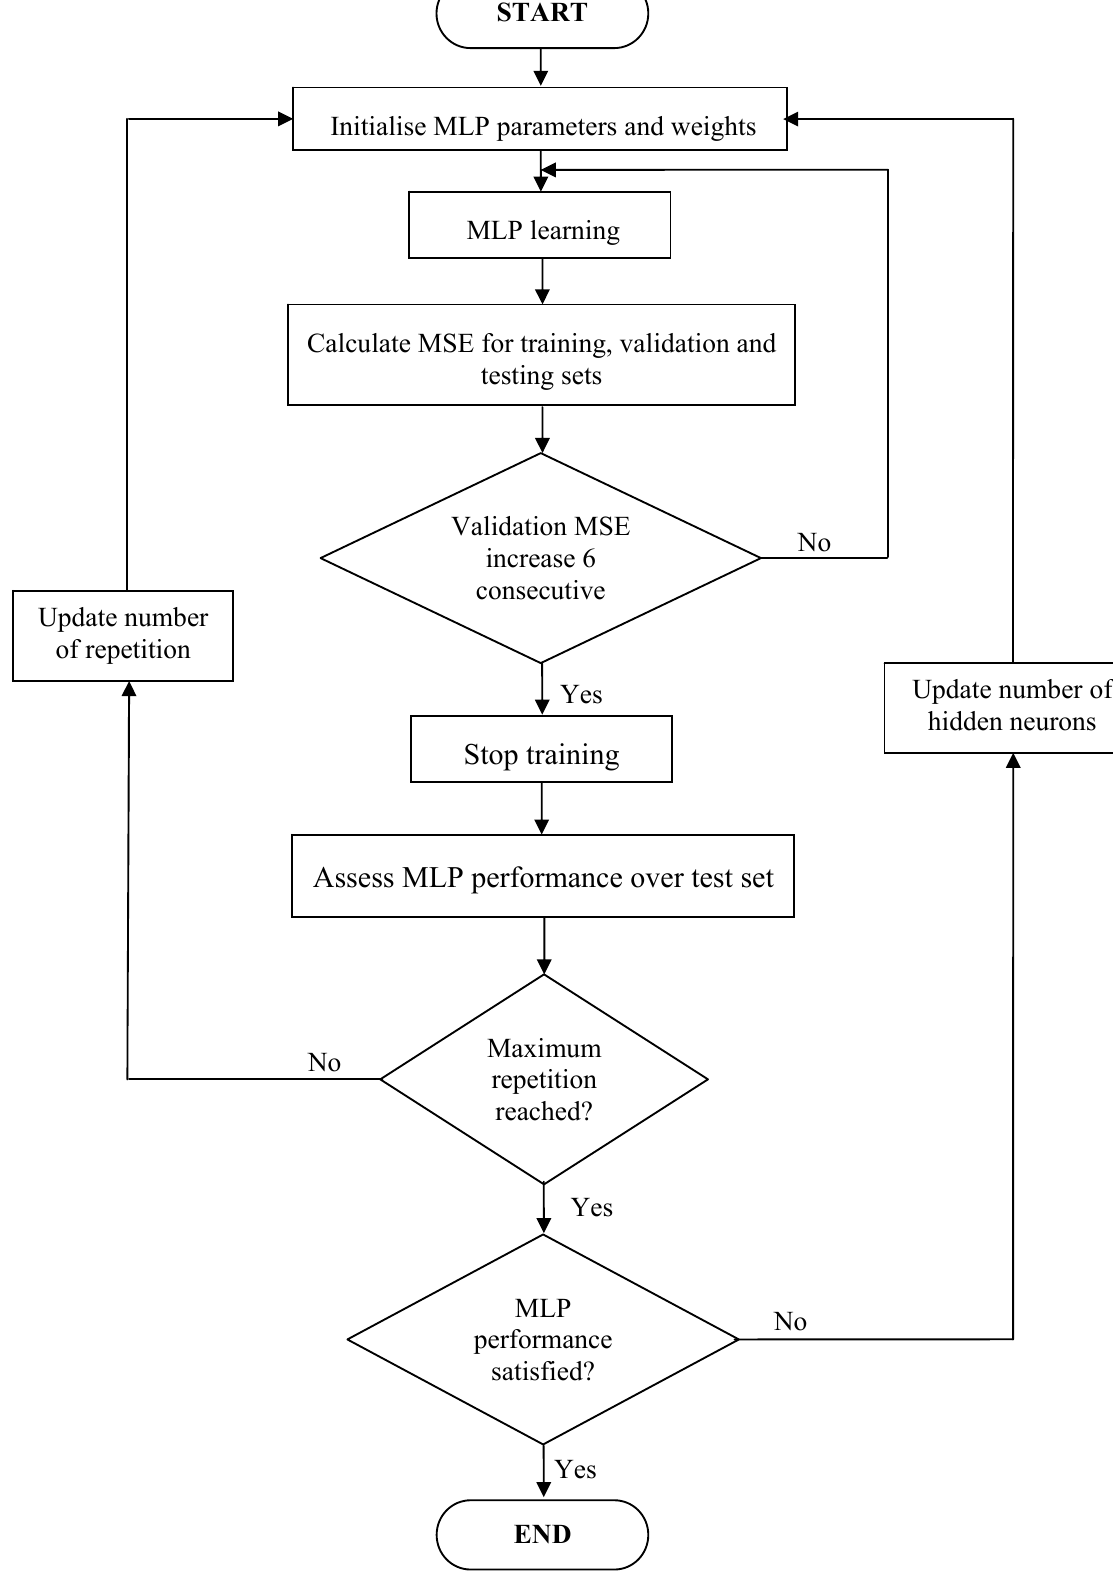
Figure 8. MLP training process to develop intelligent flow